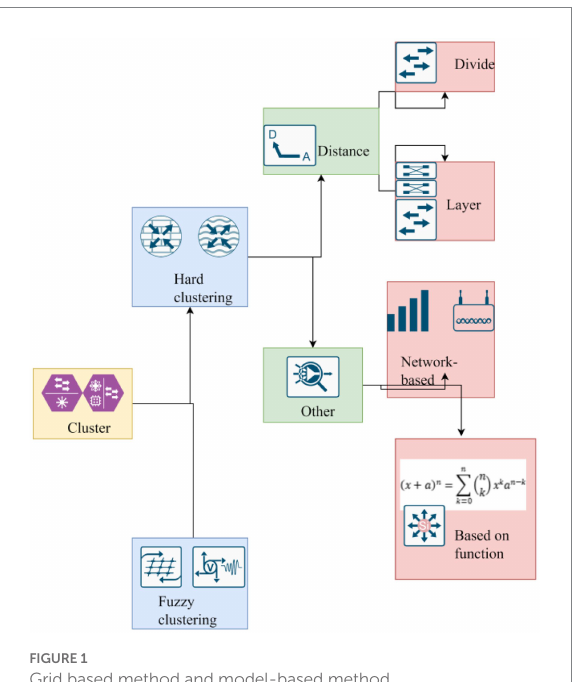
FIGURE 1 Grid based method and model-based